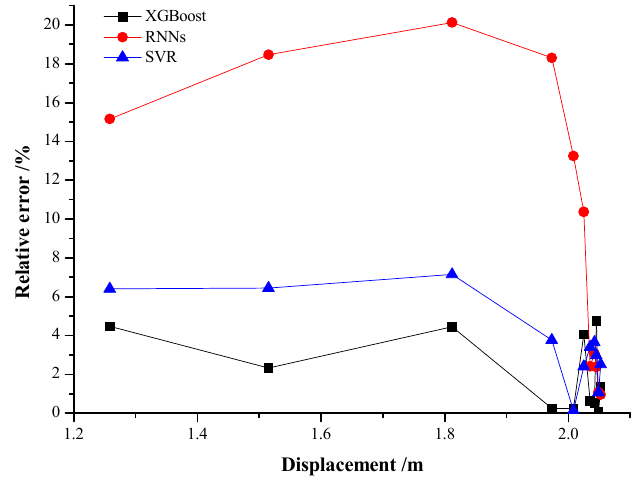
Figure 16. Variation of RE with slope displacement of D10.